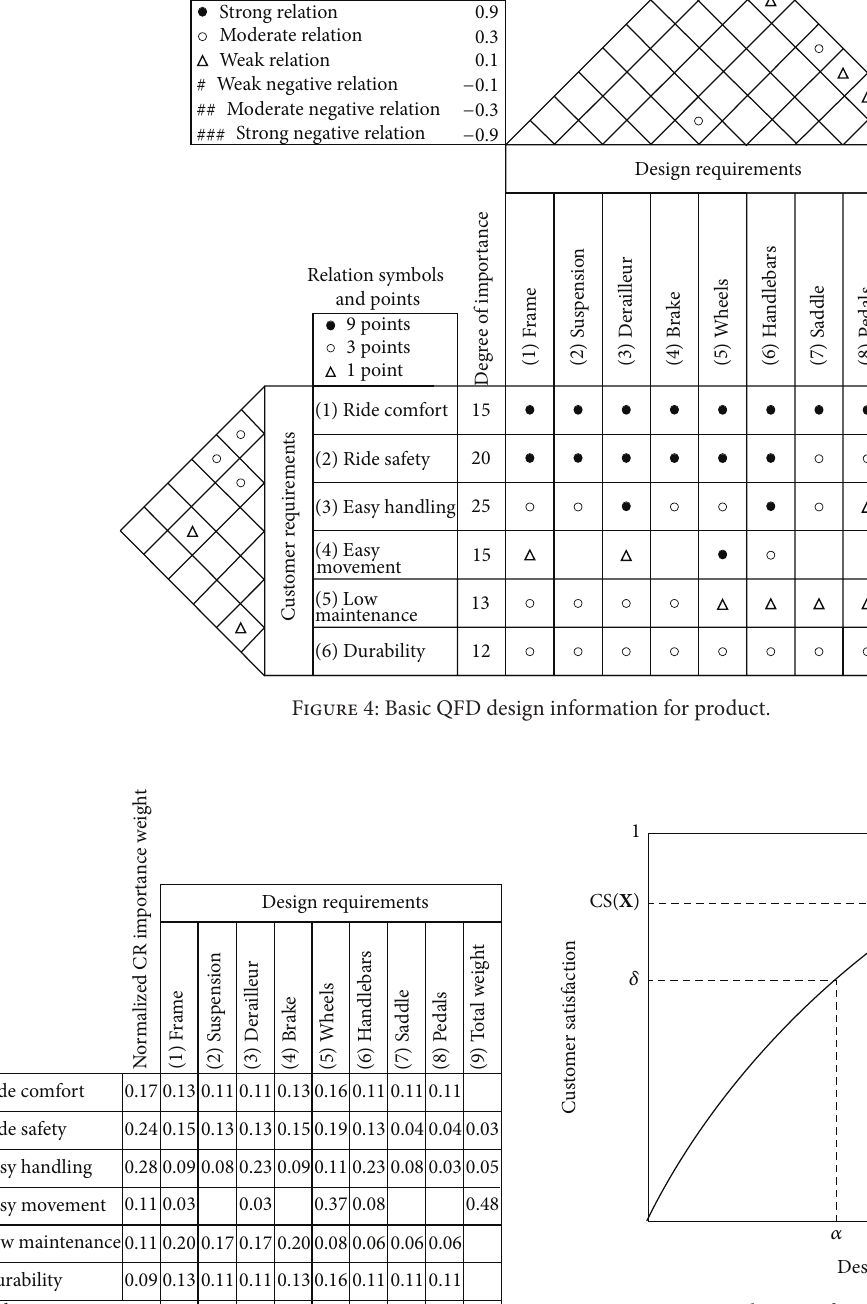
Figure 6: Functional curve of customer satisfaction for